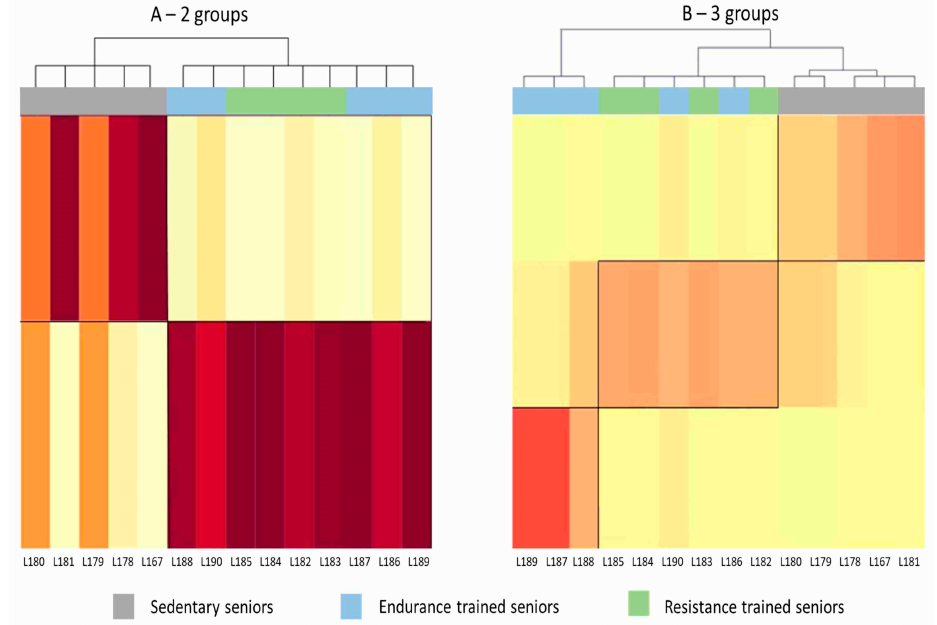
Figure 1. Heat maps generated by mixture distribution analysis. Each column represents one subject. The darker the color shade, the closer is the a ffi nity of the subject’s pattern of gene expression to that characterizing the group to which he was assigned by the cluster analysis. ( A ) Unsupervised analysis clustered subjects in two groups, SED and TRA, without being able to discriminate between ET and RT athletes. ( B ) Trying to group the subjects in three clusters (SED, ET and RT), mixture analysis misclassified two ET subjects, who were assigned to the RT group.